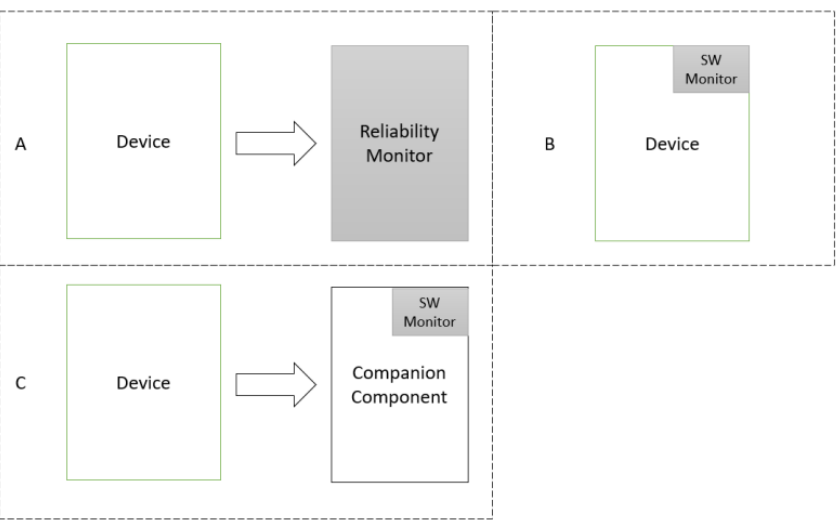
Figure 13. Ideas for online reliability monitor architectures. ( A ) reliability monitor implemented in HW ( B ) reliability monitor implemented in SW running on the same component it monitors ( C